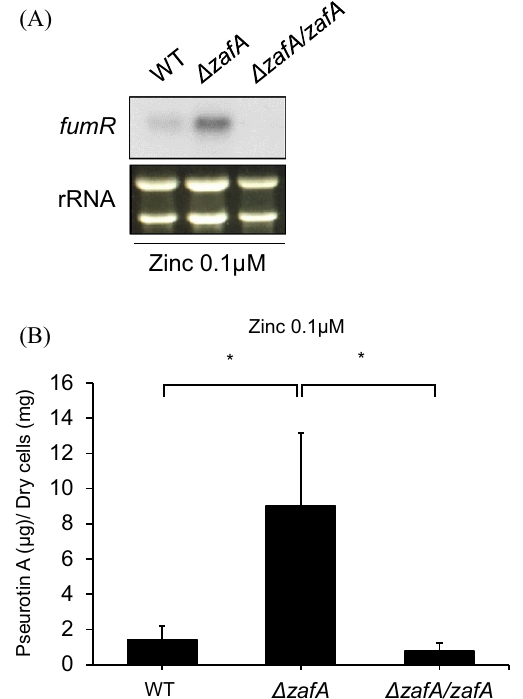
Figure 3. Pseurotin A biosynthesis was regulated by ZafA. ( A ) For determination of the effect of ZafA on fumR expression, strains complemented with zafA were constructed, and northern blotting was performed against FumR. The indicated strains were cultured in Czapek-Dox media, and total RNA was extracted to perform northern blotting. The rRNA was used as a loading control. ( B ) The biosynthesis pseurotin A was measured using the same culture media. The gray and black columns indicate gliotoxin and pseurotin A, respectively. * p < 0.05 indicates a significant difference compared to the control